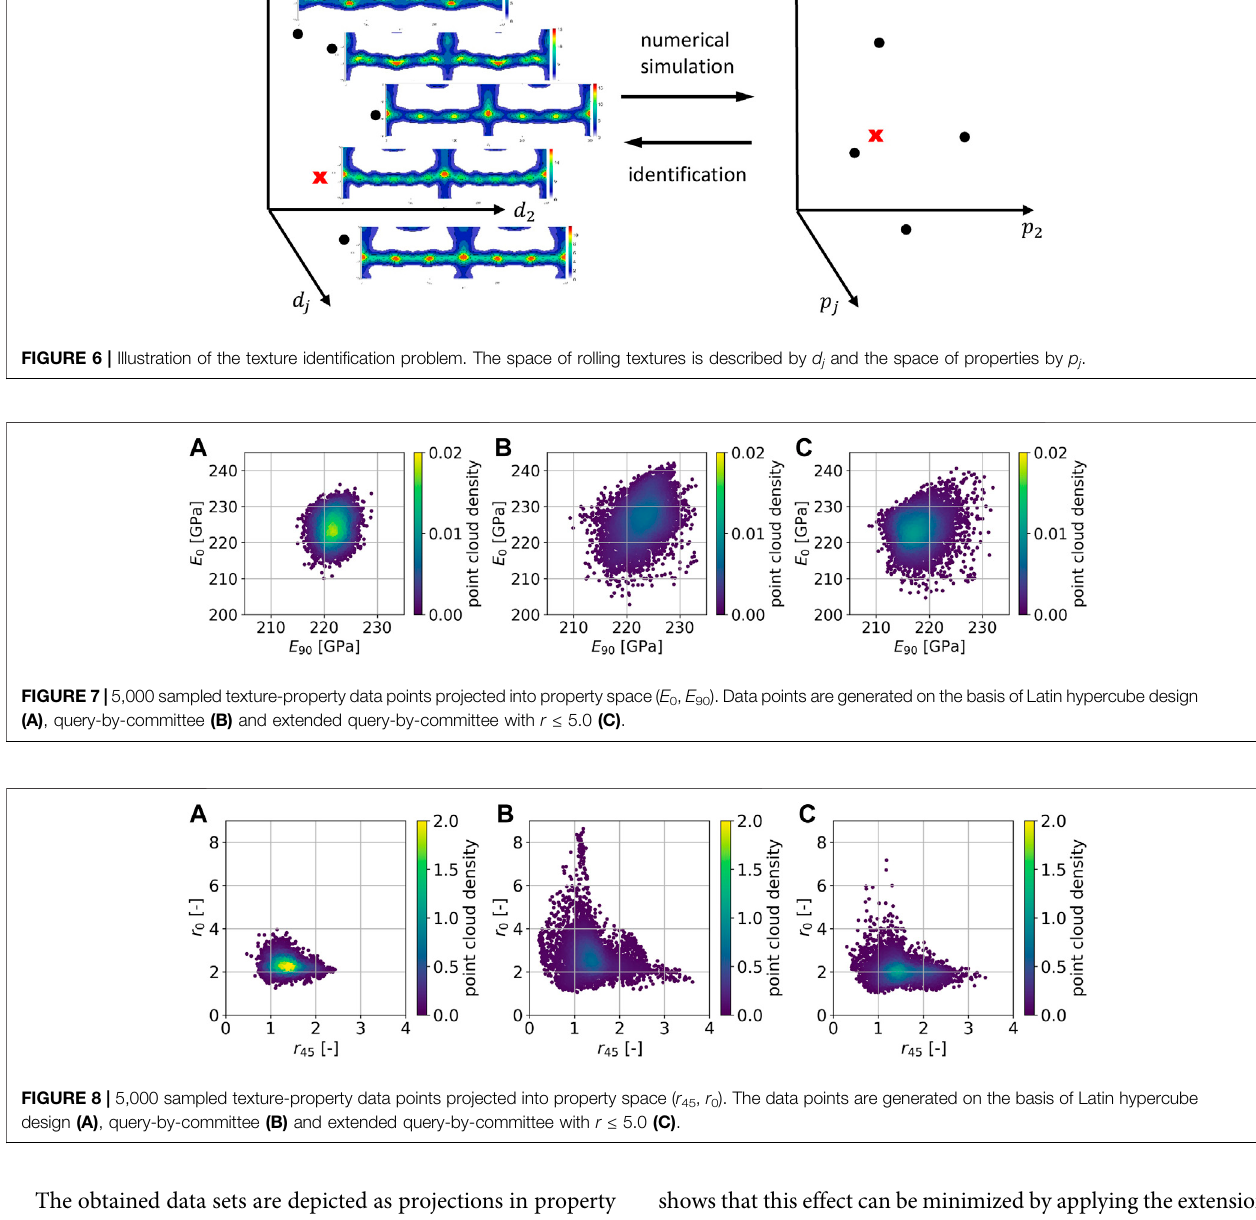
Frontiers in Materials |